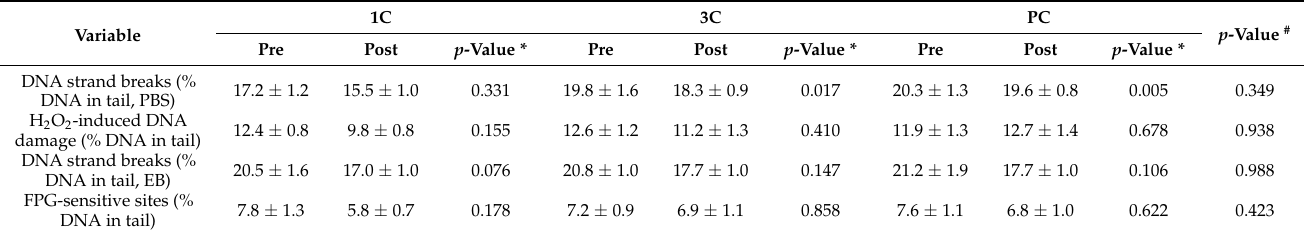
Table 2. Markers of DNA damage after each treatment ( n =